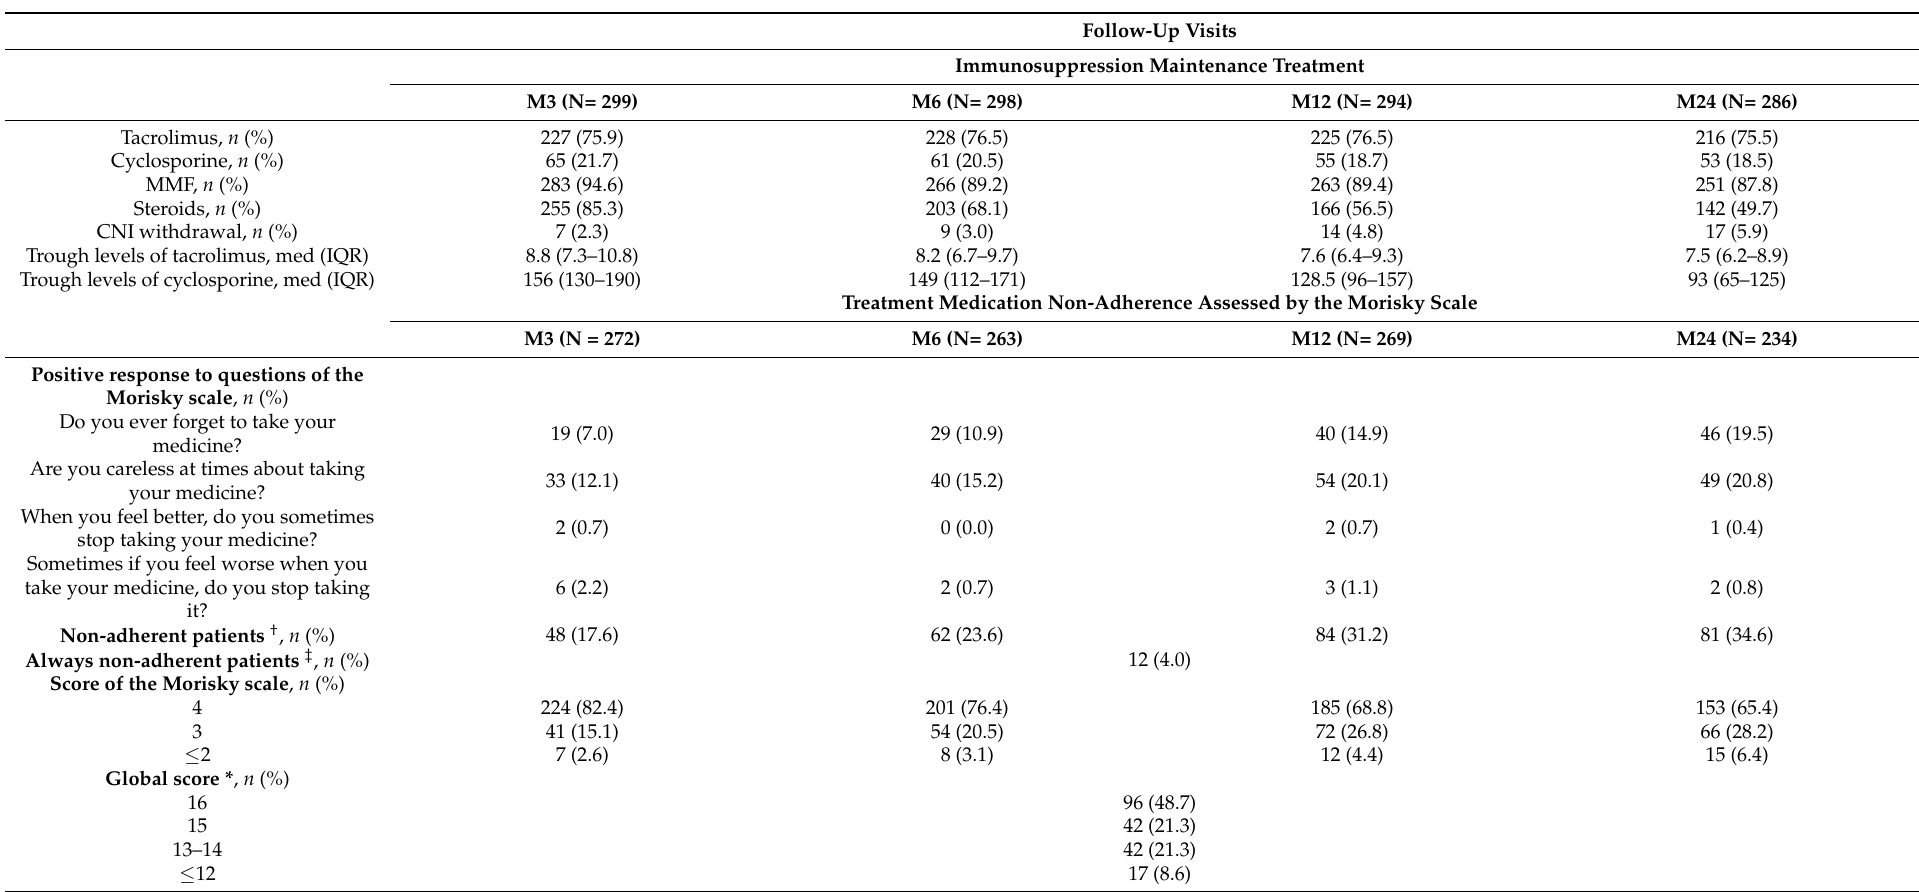
Table 2. Immunosuppression maintenance treatment and medication non-adherence assessed by the Morisky scale over